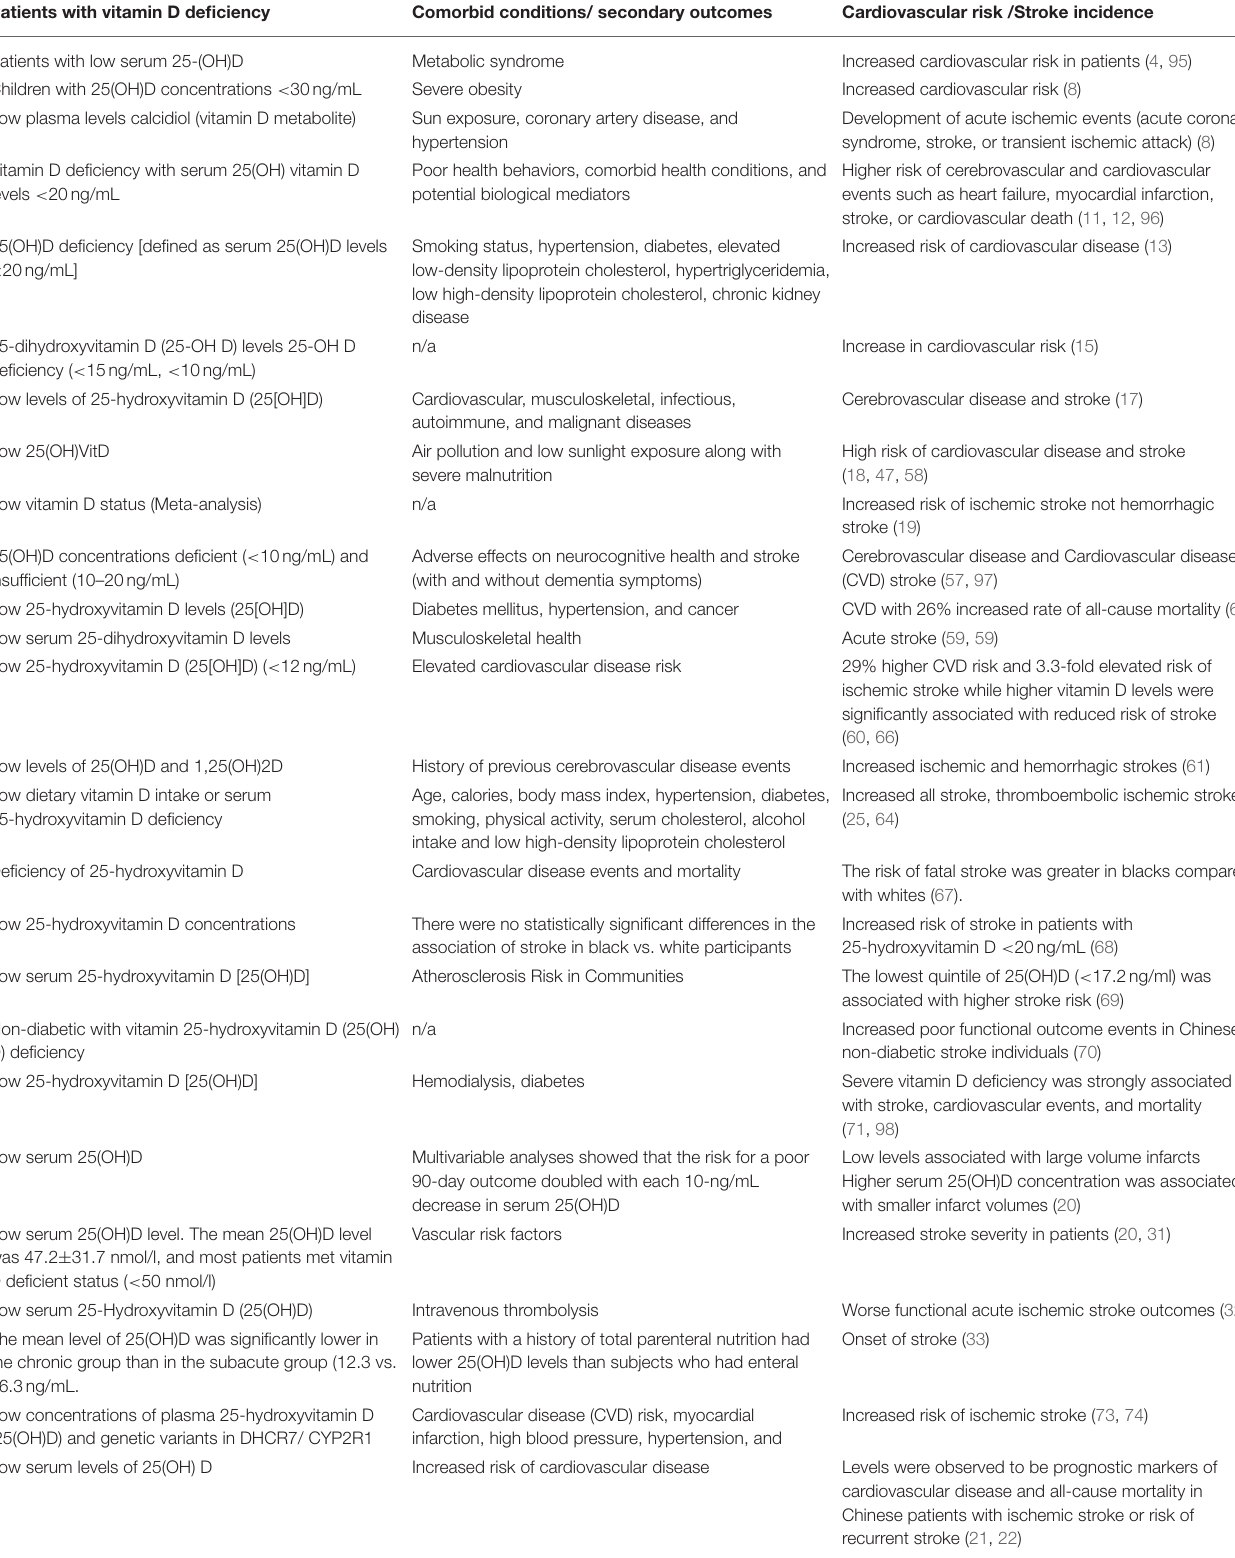
TABLE 2 | Effects of low vitamin D on stroke outcomes. Patients with vitamin D deficiency Comorbid conditions/ secondary outcomes Cardiovascular risk /Stroke incidence Patients with low serum 25-(OH)D Metabolic